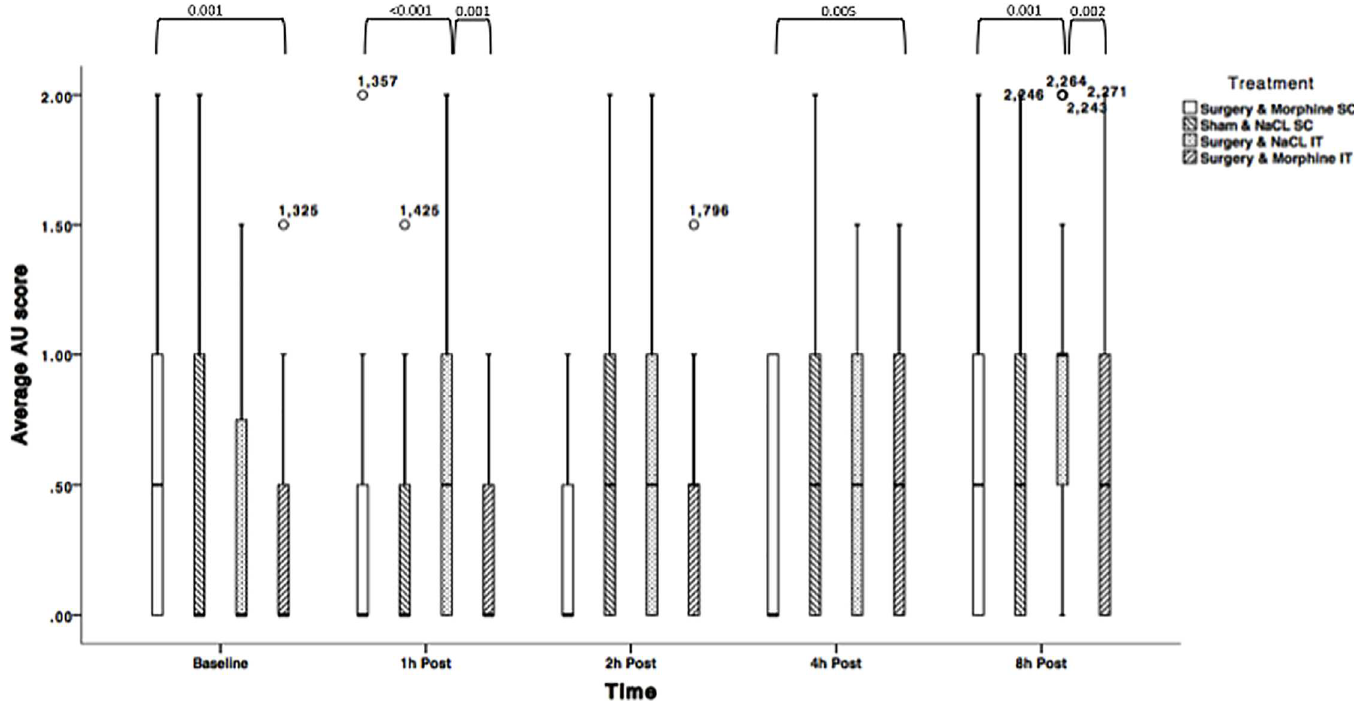
Fig 5. Average Action Unit RGS scores for treatments 2.1 (NaCl SC + sham surgery); 2.2 (NaCl IT + surgery); 2.3 (morphine SC + surgery) and 2.4 (morphine IT + surgery) over time (Solid line = median, box = 1 st and 3 rd quartiles, whiskers = minimum and maximum, $ , (cid:14) = Outliers). N = 28. P - values are indicatedwhere differences are significant ( < 0.05).